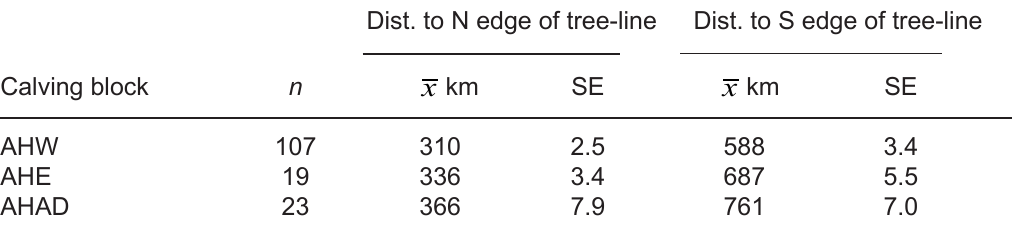
Table 8. Distance (km) from calving locations within 3 calving blocks on the Ahiak calving ground, 1997-2010, to the north (N) and south (S) of forest – tundra biome (Timoney et al,. 1992, Payette et al.,